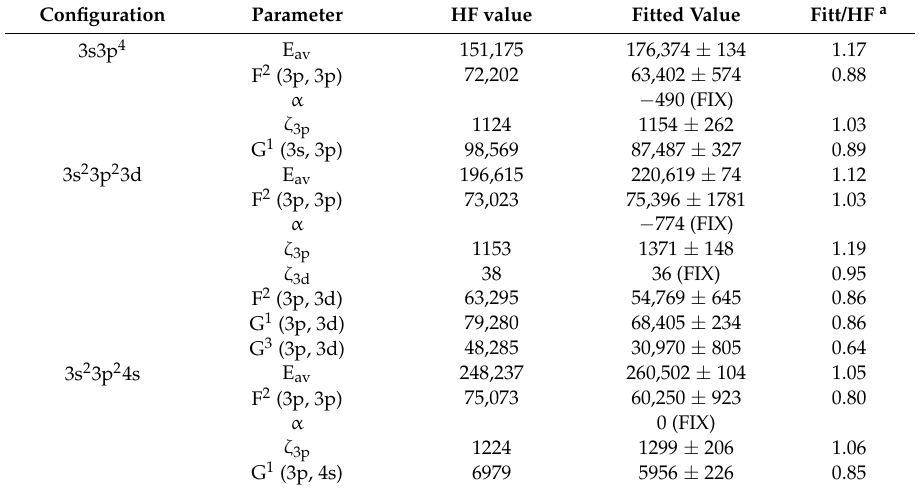
Table 8. Energy parameters (cm − 1 ) for the studied even parity configurations of Ar